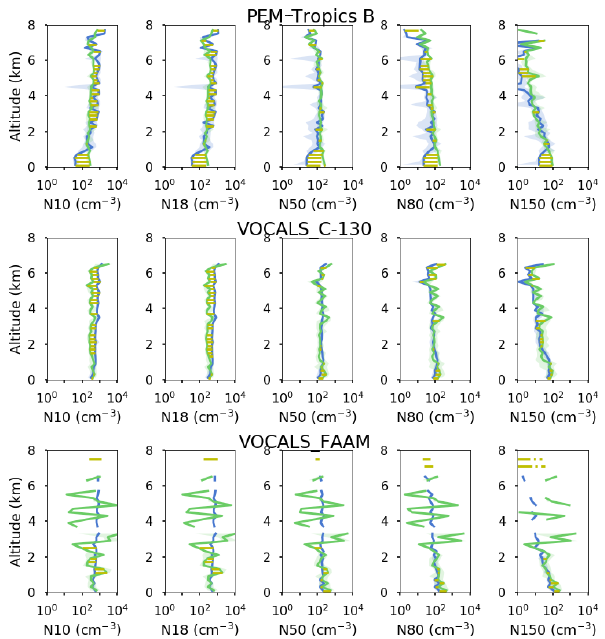
Figure C4. Per-campaign median profiles of aerosol number at different sizes. Yellow lines indicate a significant difference at that